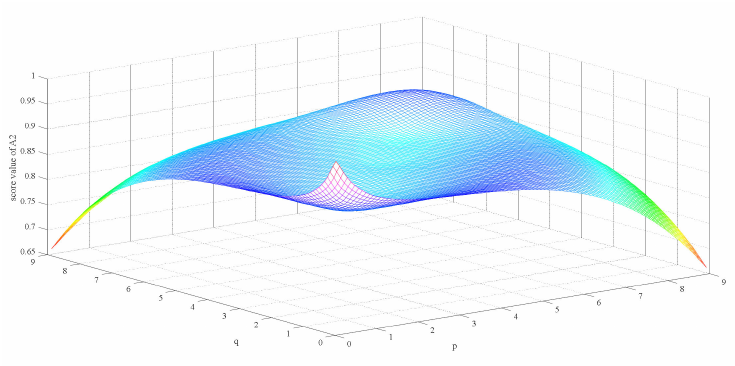
Figure 2. Score value of medical surgical mask ( A 1 ) when p , q ∈ [ 0.1,9 ] .